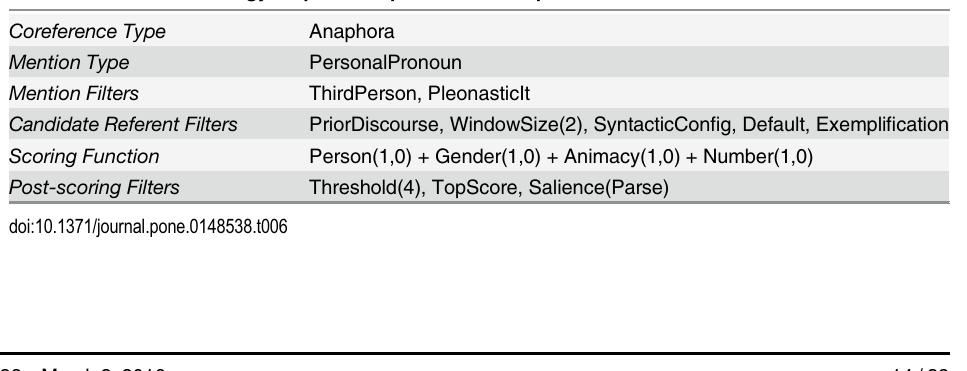
Table 6. Resolution strategy for personal pronominal